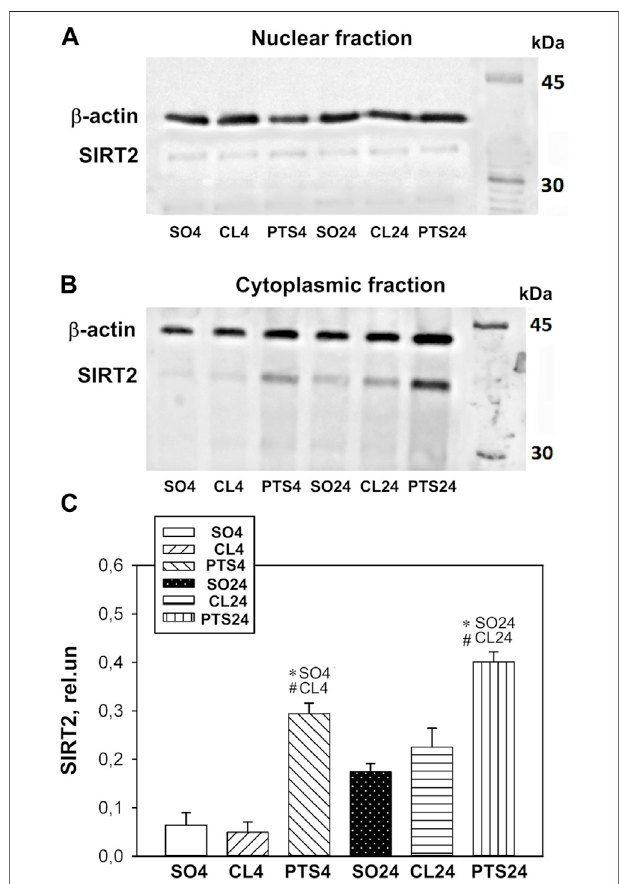
FIGURE 4 | SIRT2 expression in nuclear (A) and cytoplasmic (B,C) fractions of penumbra tissue 4 or 24 h after photothrombotic stroke in the cerebral cortex of rats. One-way ANOVA. N ± SEM. n = 7. * p < 0.05 compared to sham-operated animals, # p < 0.05 compared to the contralateral cerebral cortex of the same